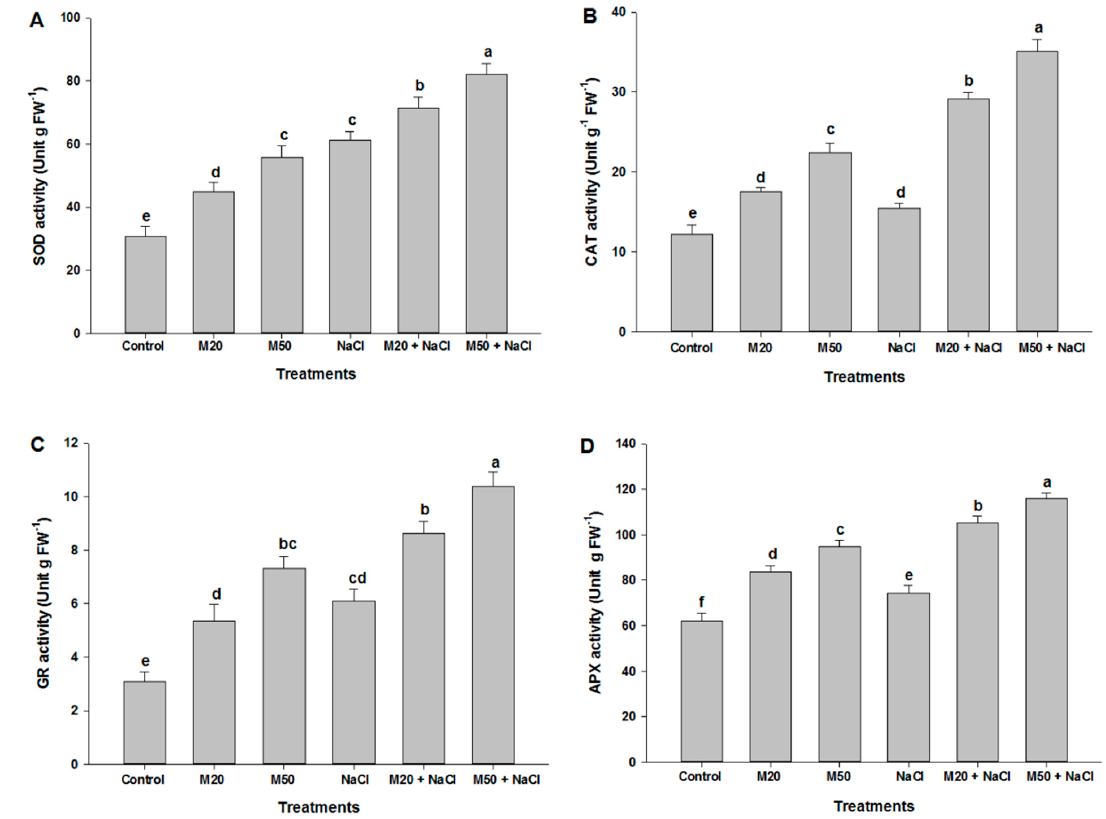
Figure 10. E ff ect of melatonin on the activities of ( A ) superoxide dismutase (SOD), ( B ) catalase (CAT), ( C ) glutathione reductase (GR) and ( D ) ascorbate peroxidase (APX) in leaves of tomato seedlings under salinity. Data represent mean of 4 replicates with bars indicating SE. The bars labelled with di ff erent letters are significantly di ff erent at p < 0.05%. [DDW (control), 20 µ M melatonin (20M), 50 µ M melatonin (50M), 100 mM NaCl (NaCl)].